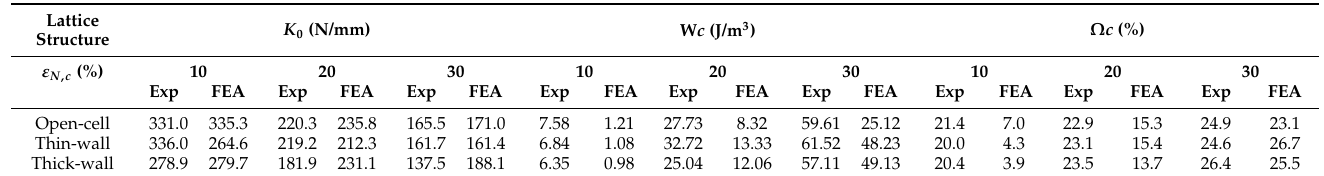
Table 5. Experimental and simulated lattice structure stiffness and energy absorption.